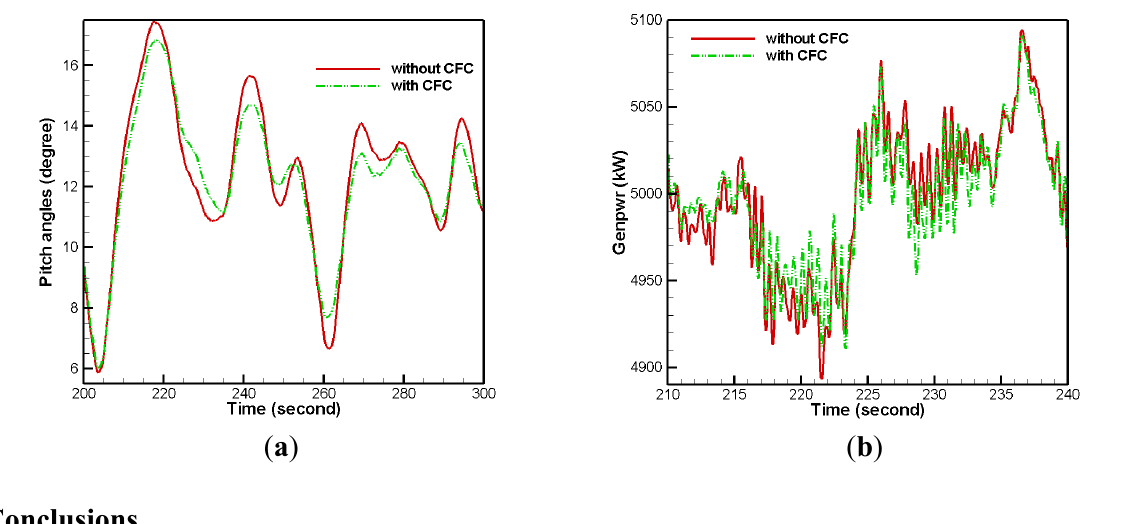
Figure 8. Time domain results with and without CFC at NTM 16 m/s; ( a ) pitch angles; ( b ) generator